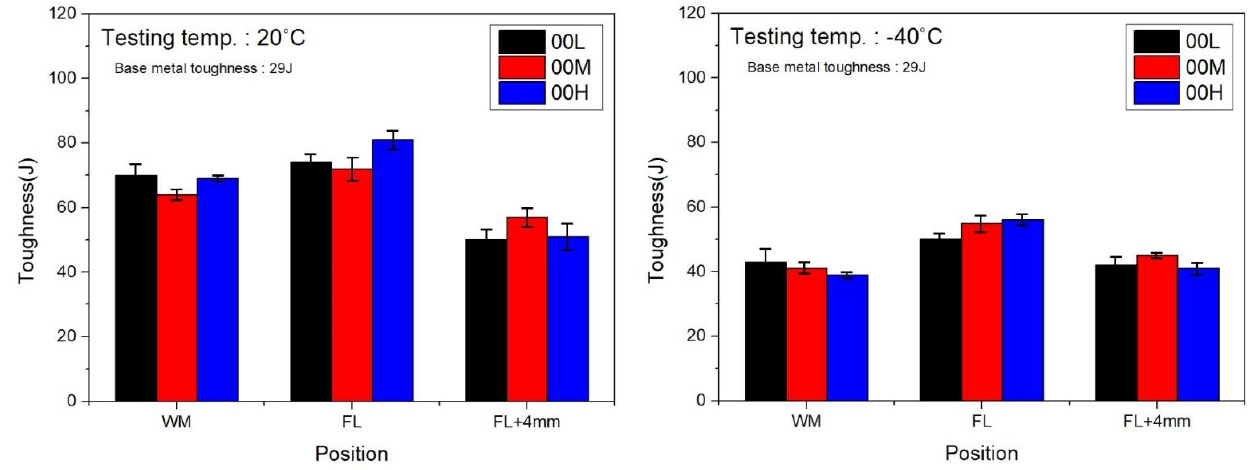
Figure 15. Toughness results of FCAW with CO 2 5% and 20% shielding gas and heat input at room temperature (20 °C) and low temperature ( − 40 °C).